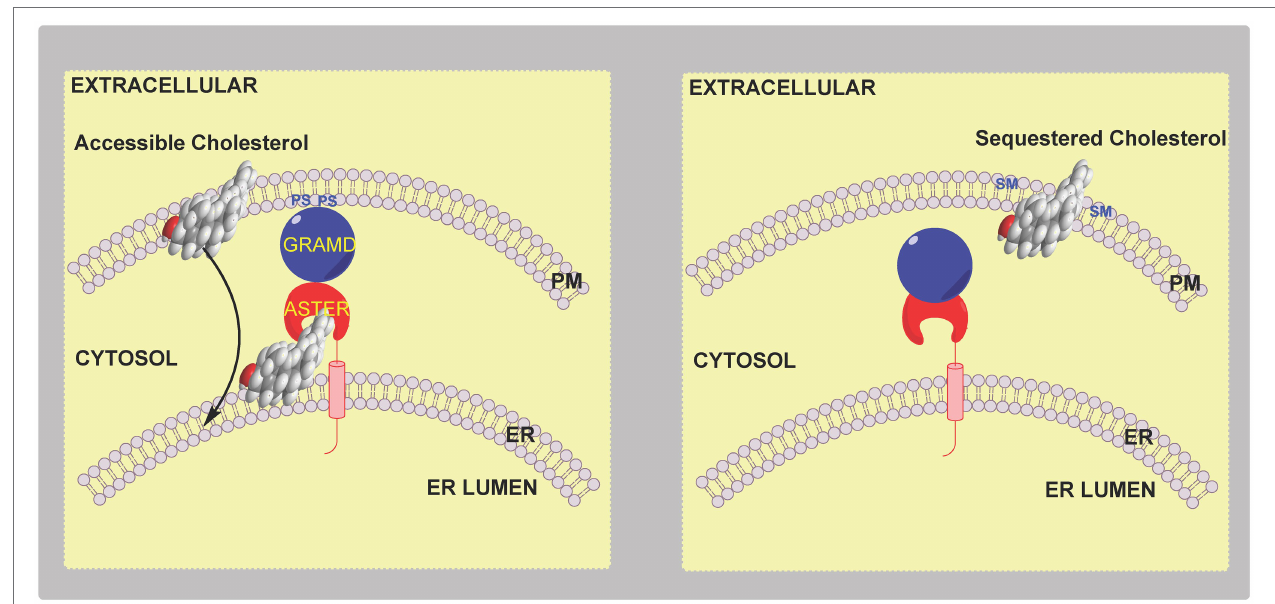
FIGURE 4 | Cartoon illustration of the involvement of Aster proteins in cholesterol transport and regulation. Left panel , an elevation in accessible cholesterol leads to presentation of PS on the inner leaflet of the plasma membrane and formation of a membrane contact site via the GRAM domain of the endoplasmic reticulum resident protein Aster. Accessible cholesterol is then transferred by the ASTER domain of the protein from the plasma membrane to the endoplasmic reticulum to be sensed by the SREBP-machinery. Right panel , when accessible cholesterol in the plasma membrane is below a critical level there is no binding of the Aster protein to the plasma